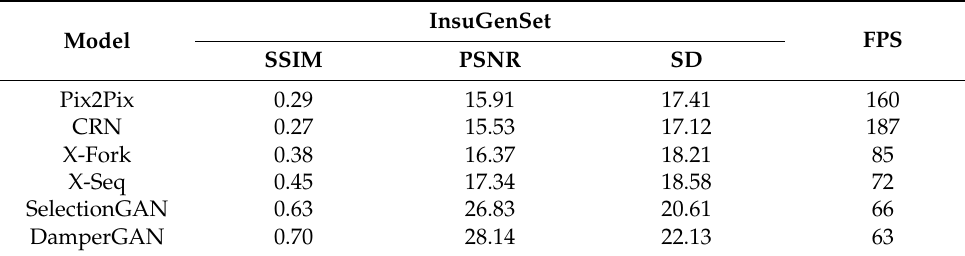
Table 4. SSIM, PSNR, SD, and FPS of the different models.